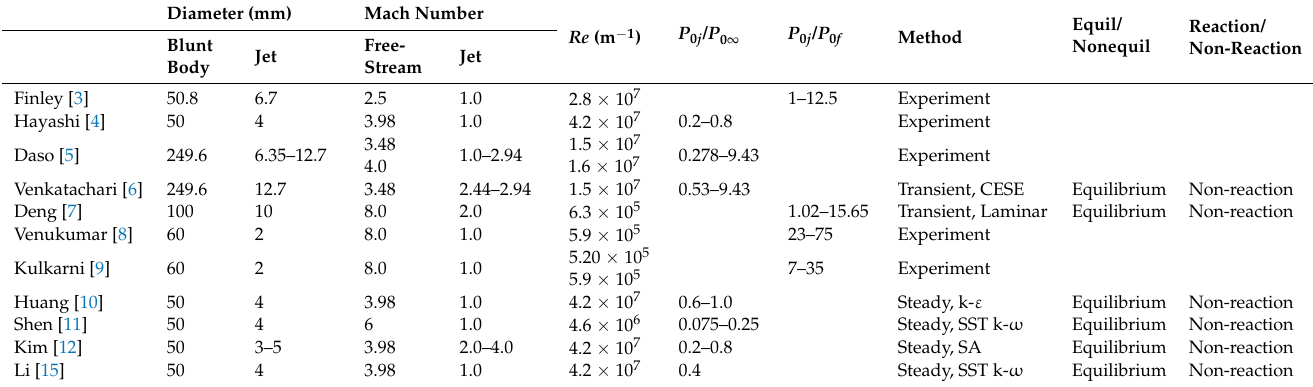
Table 1. Related research of opposing